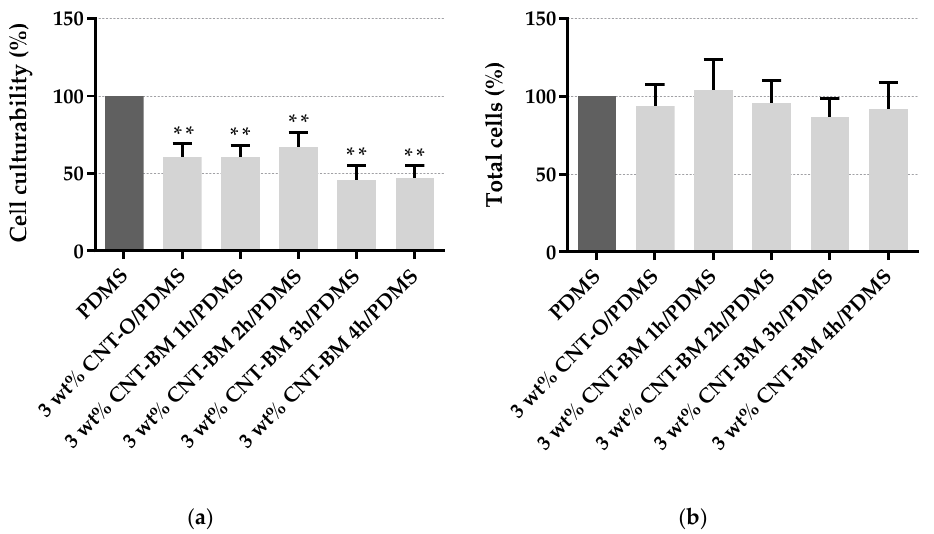
Figure 4. Percentage of E. coli CECT 434 GFP ( a ) culturable and ( b ) total cells after 24 h of biofilm formation on PDMS (control) and CNT/PDMS composite surfaces with different CNT-O loading (ranging from 0.1 to 5 wt%). The means ± standard error (SE) for three independent experiments are illustrated. Significant differences were considered for p -values < 0.05 (** p < 0.001).